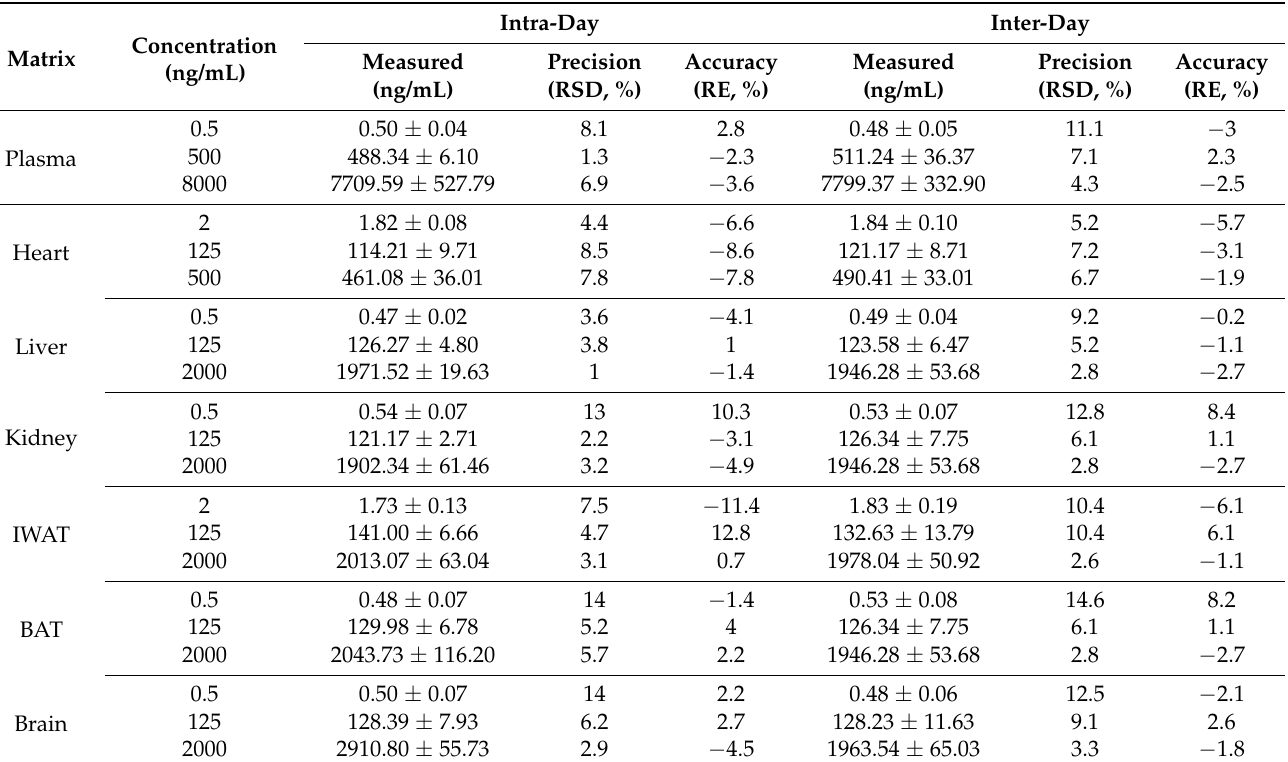
Table 3. Precision and accuracy of 13 C 4 SA in mouse plasma and tissues (mean ± SD, n =